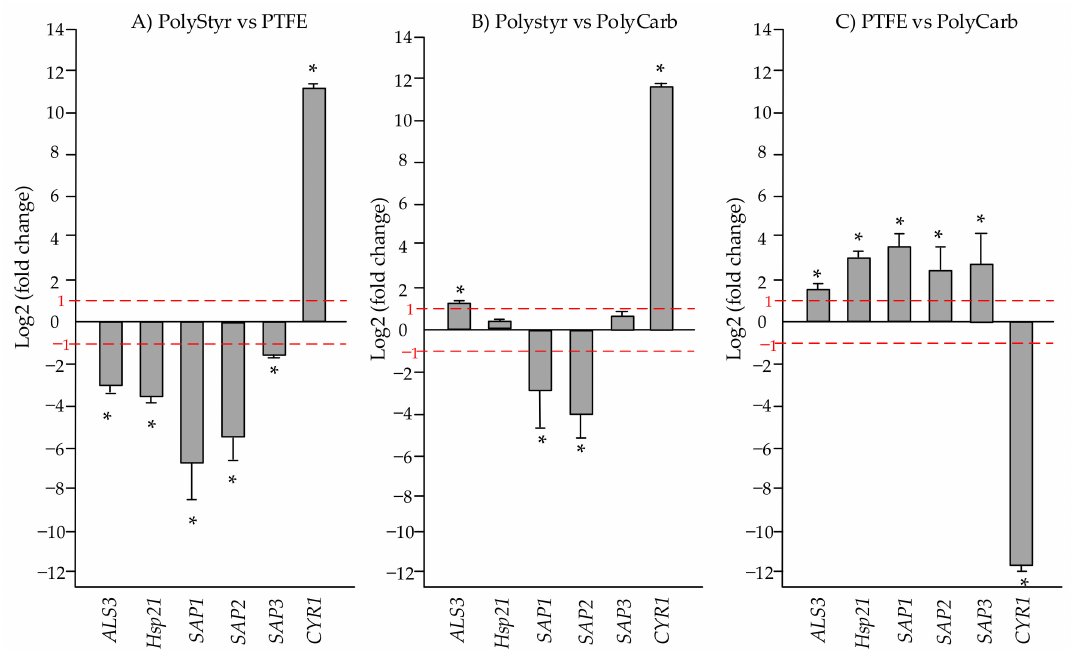
Figure 9. Mean relative mRNA expression levels of virulence and stress response genes of clinical isolate of C. tropicalis . ( A ) Polystyrene vs. polytetrafluoroethylene (PTFE); ( B ) polystyrene vs. polycarbonate; ( C ) PTFE vs. polycarbonate. Fold changes are calculated according to the formula fold change = 2 − ∆∆ Ct by using Ct (threshold cycle number) generated by the qRT-PCR system. Reported fold changes are the means of three replicate experiments. Fold changes significantly different from 1 ( p value < 0.05) are marked by an asterisk. Red broken lines indicate fold change thresholds of 2 and 0.5